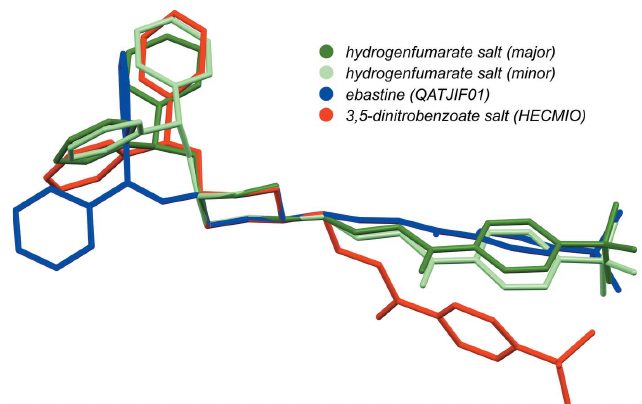
Figure 7 An overlay of the major and minor conformations of the ebastinium cation in I (this work) with ebastine (CSD: QATJIF01) and ebastinium cation from the 3,5-dinitrobenzoate salt (CSD: HECMIO, major conformation only), from a least-squares fit of non-H atoms in the piperidine/piperidinium rings. The axial placement of the diphenylmeth- oxy group (at left) in the salts is clearly different from the equatorial placement of the free base (blue). For the sake of clarity, only the major disorder component of HECMIO is shown. Diagram generated using Mercury (Macrae et al. ,